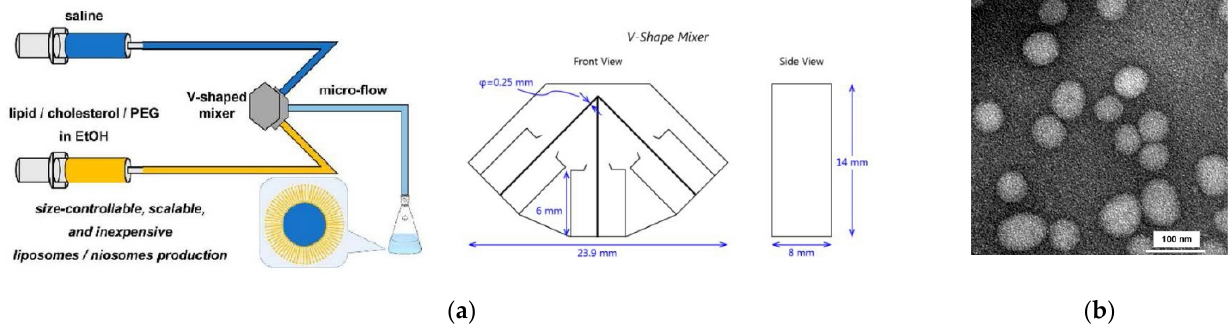
Figure 18. Size-controlled and scalable production of LUVs based on the “ethanol injection method” by using a V-shaped mixer (diameter: 250 μ m) and a micro-flow reactor, with an outlet tube diameter of 1 mm, as published by Kawamura et al. (2020) [218]. ( a ) Schematic representation of the set-up and details of the stainless steel V-mixer. The procedure was shown to be applicable for the preparation of lipid vesicles from mixtures of amphiphilic phospholipids (e.g., DSPC:cholesterol:DSPE-PEG2000 (10:10:1, molar ratio) as well as for vesicles prepared from non-ionic surfactants (“niosomes”). The size of the obtained vesicles was in the range of 50–70 nm depending on the experimental conditions; see text and [218]. ( b ) Negative staining transmission electron microscopy image of one of the lipid vesicle dispersion obtained, analyzed after mixing with an EM stain solution (containing a lanthanide salt) and then analyzed in the dry state at room temperature (bar: 100 nm) [218]. Reproduced with permission from [218], American Chemical Society, 2020.